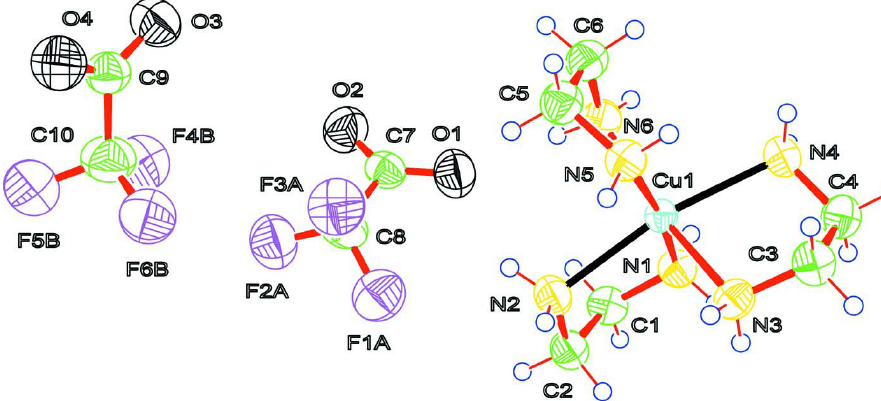
A view of the title compound, with the atom numbering scheme. Displacment ellipsoids are shown at the 50% probability level. H atoms are drawn as small spheres of arbitrary radius. Only the major disorder components are